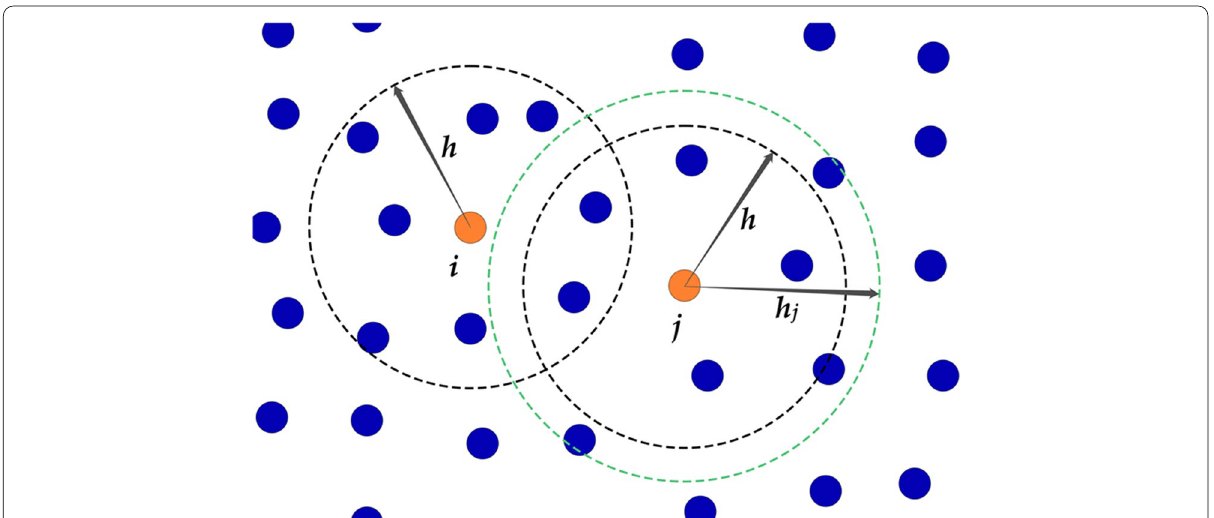
Fig. 1 Illustration of the variable smoothing length concept. The smoothing length of particle i is the default value h owing to the uniform distribution of particles around it, while the smoothing length of particle j has to be expanded from h to h j to maintain sufficient number of neighbors, owing to the sparse distribution of neighboring